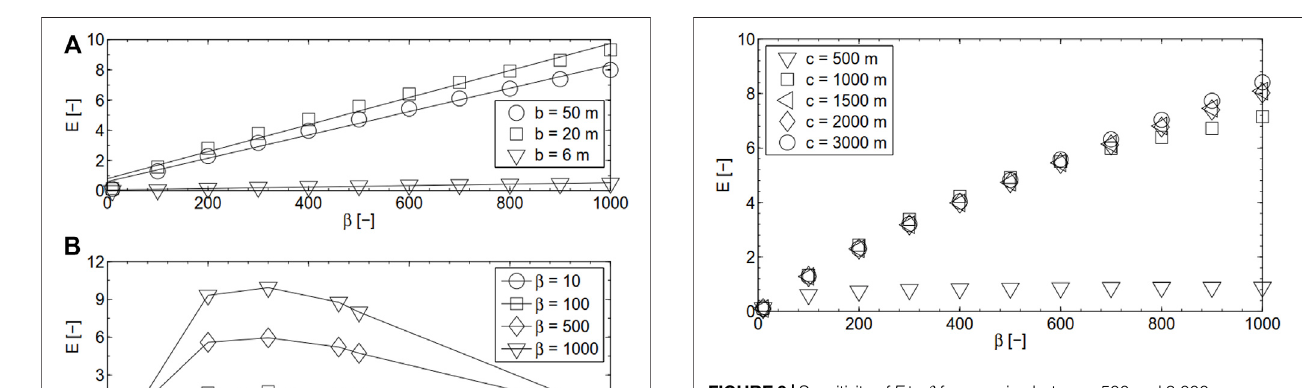
FIGURE 9 | Sensitivity of E to β for c varying between 500 and 3,000 m, in which a = 2 m and b = 50